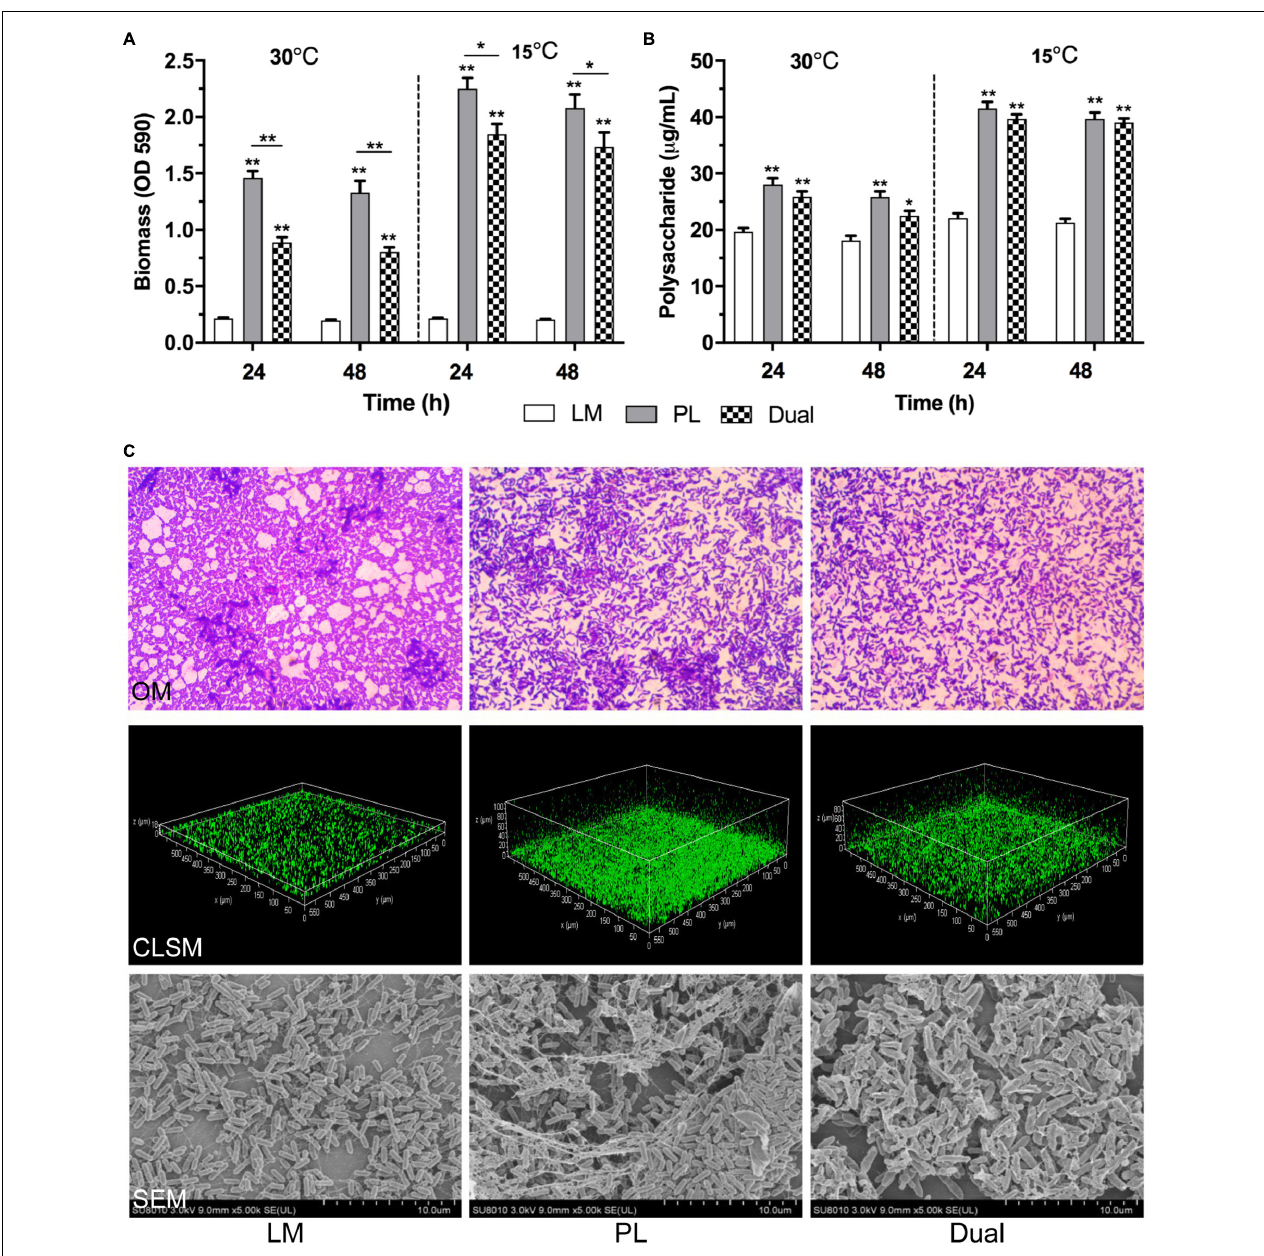
FIGURE 1 | Biofilm formation of L. monocytogenes and P. lundensis as mono- and dual species at 30 and 15 ◦ C. (A) Biofilm biomass by CV, (B) polysaccharides production, and (C) OM images (1,000 × ), CLSM staining living cells by SYTO9 (20 × ) and SEM images (4,000 × ). Data were expressed as mean ± standard deviations ( n = 3). * p < 0.05; ** p < 0.01: significant interspecies